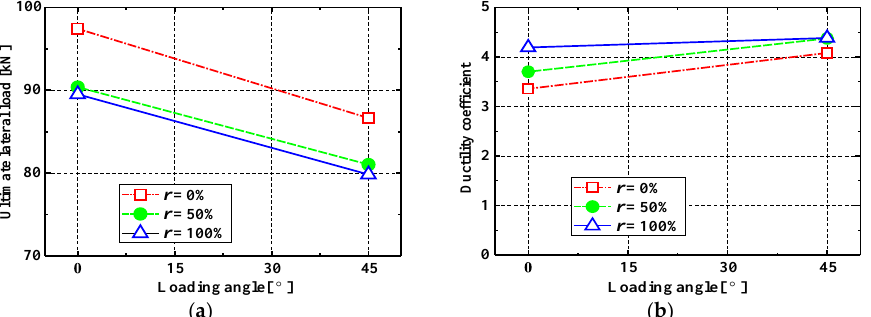
Figure 16. Effect of bi-directional loading on the seismic performance of RRC columns. ( a ) Capacity. ( b ) Ductility.